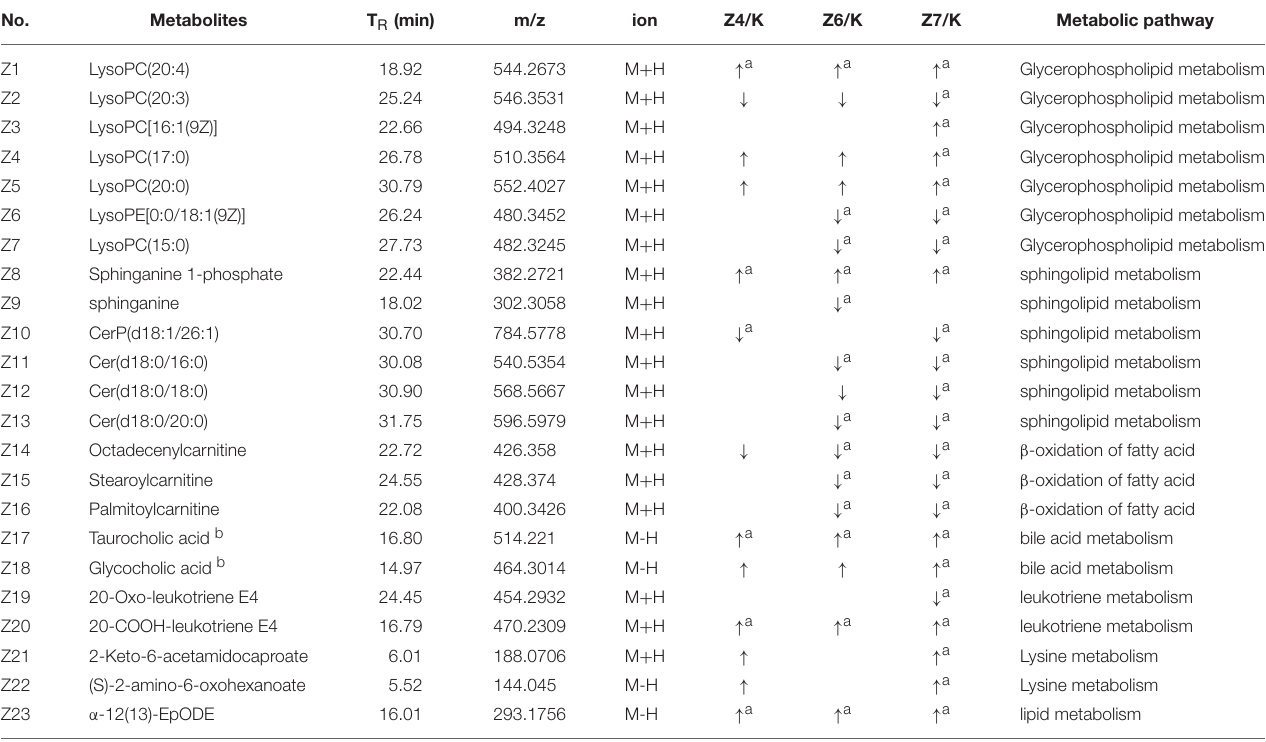
↑ shows up-regulated metabolite; ↓ shows down-regulated metabolite. a Means a statistically significant difference at p < 0.05. b Validated with standard. [Z4] group compared with [K] group, Z4/K; [Z6] group compared with [K] group, Z6/K; [Z7] group compared with [K] group,